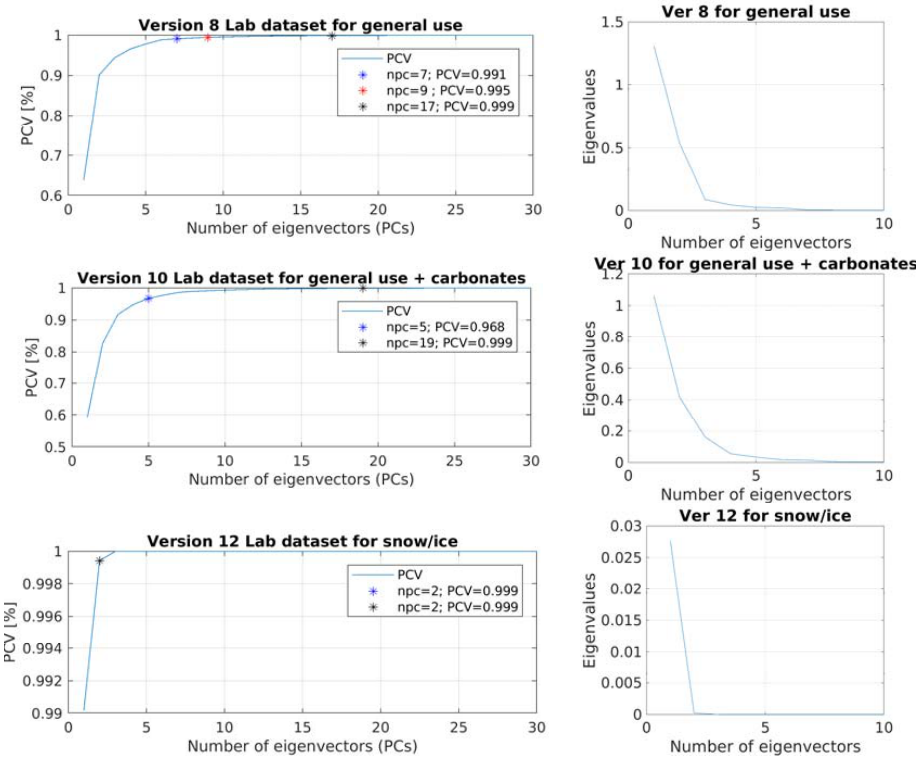
Figure 9. ( Left ) Percentage cumulative variance (PCV) function of the three selected laboratory measurement sets as a function of the number of principal components (PCs). The chosen number of PCs is indicated with blue or red stars. The legend contains the corresponding PCV values. Black stars stand for the number of PCVs, which reached the 0.999 value. ( Right ) The mean eigenvalues of the laboratory datasets for the first 10 eigenvectors.